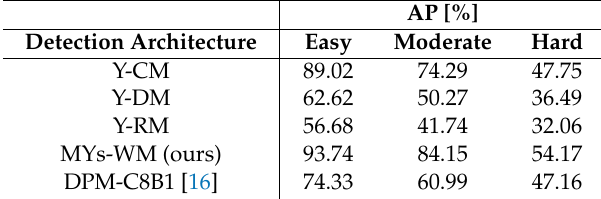
Table 3. Comparison of detection results of cars classified by di ffi culty.